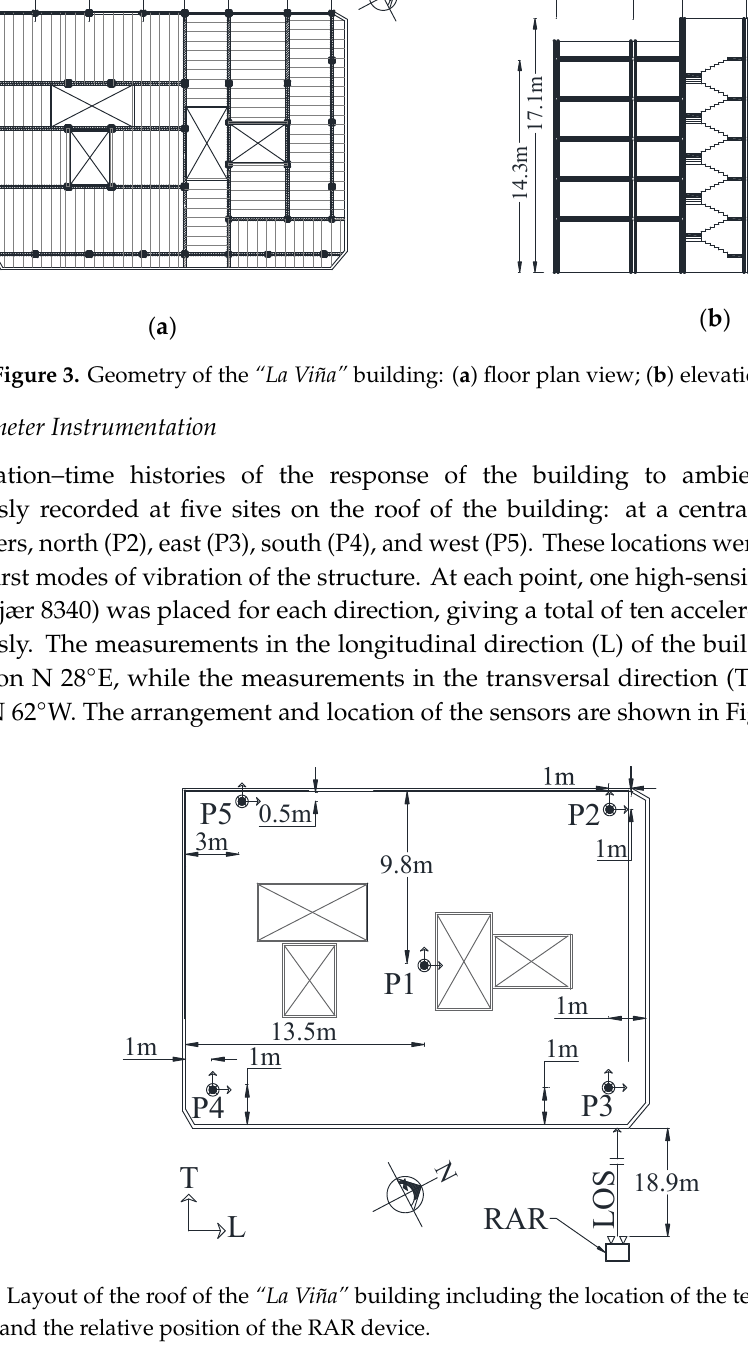
Figure 2. Main façades of the “La Viña” building: ( a ) longitudinal orientation, L; ( b ) transversal orientation, T.